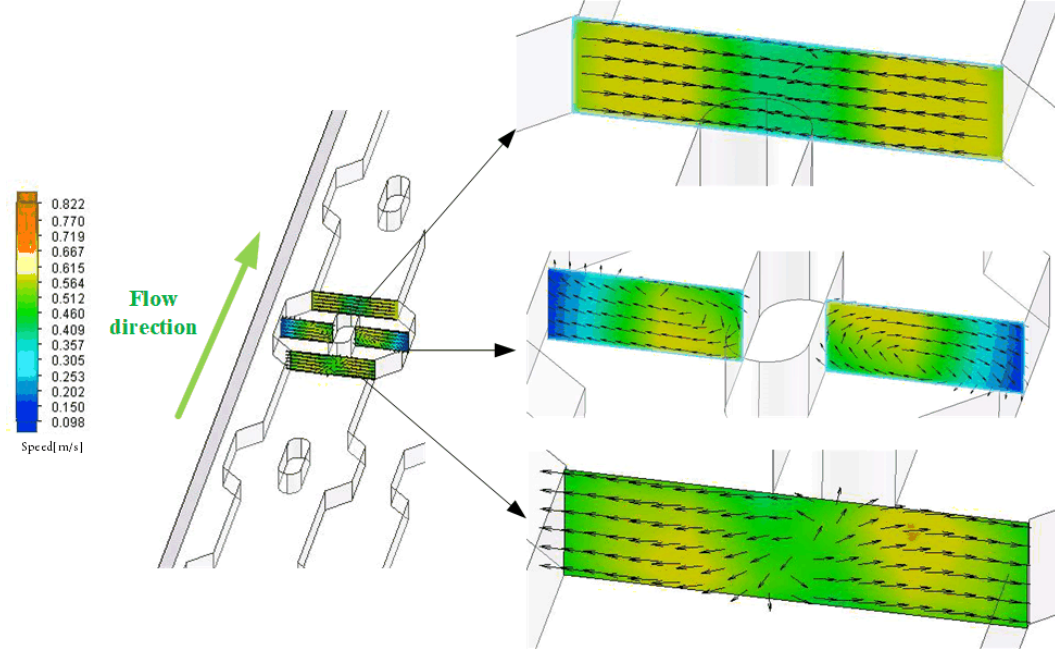
Figure 15. Cross-sectional view of flow velocity at different locations.